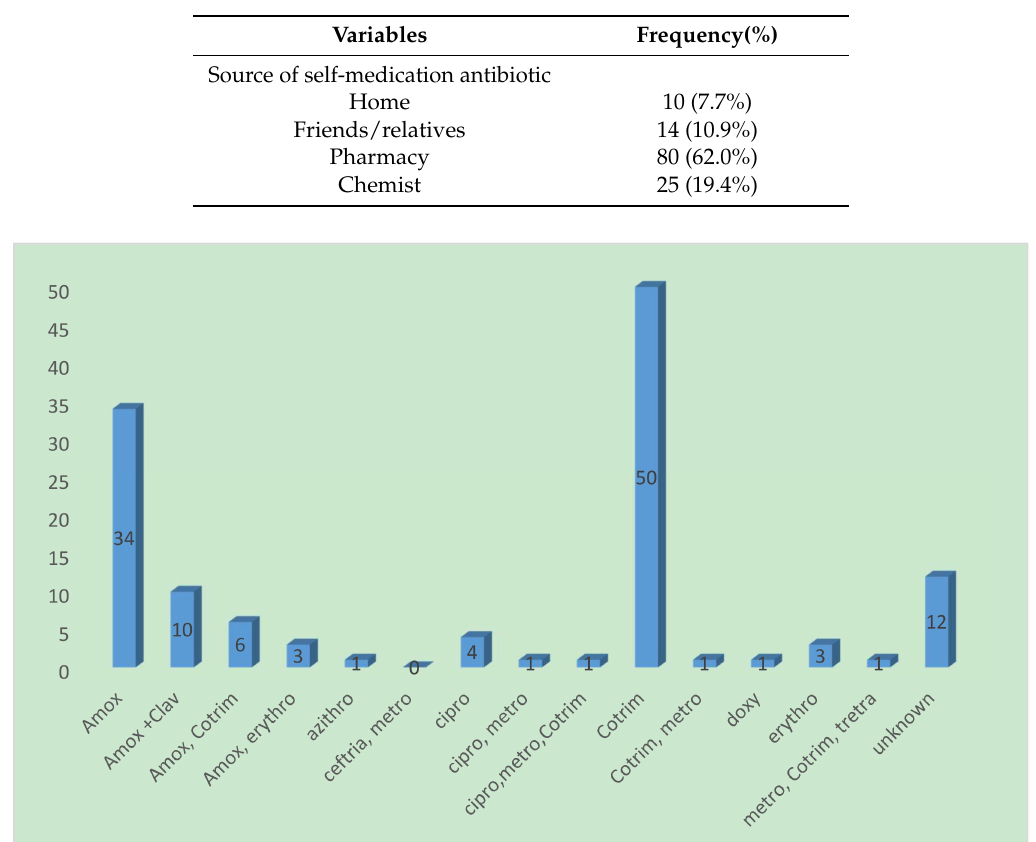
Figure 1. Frequency of various self-medication antibiotics used by participants. Amox = Amoxicillin; Ceftriaxone = Ceftriaxone; Clav = Clavulanic acid; Azithro = Azithromycin; Cotrim = Cotrimoxazole; Metro = Metronidazole; Erythro = Erythromycin; Cipro = Ciprofloxacin; Doxy = Doxycyclin.